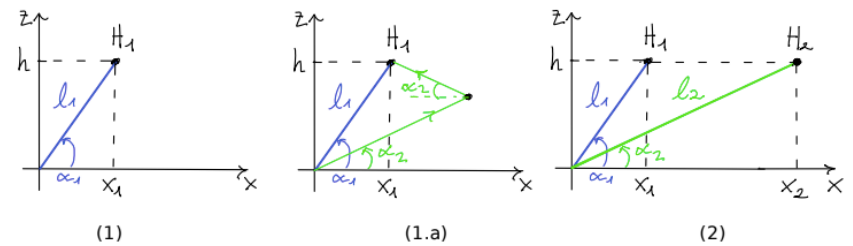
Figure 4. Two paths for reaching the height z = h : path ( 1 ) has a length l 1 and an angle α 1 ; path ( 1.a ) reaches the same destination as ( 1 ) by keeping a lower constant slope with a longer length. Path ( 2 ) is used in the proof and is equivalent to path ( 1.a ) in the angle α 2 and length l 2 . The paths are compared in terms of fuel savings under different configurations, as shown in Figure 5.